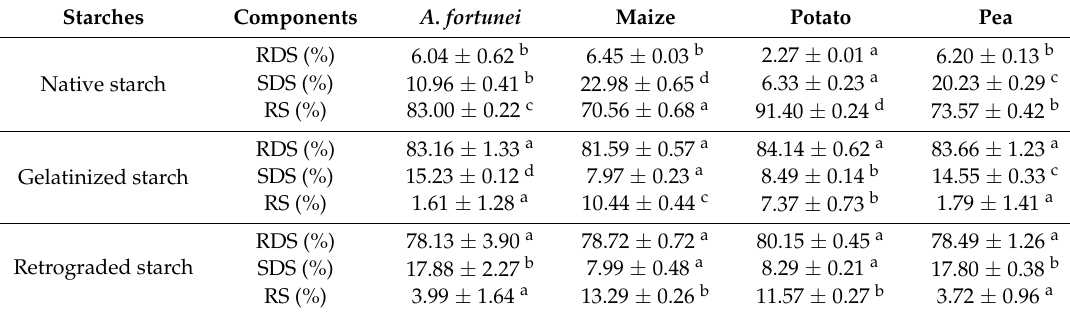
Table 6. Digestion properties of